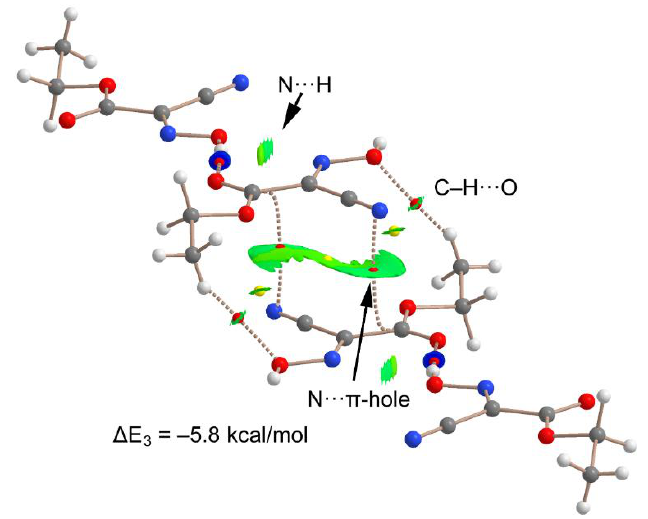
Figure 6. QTAIM/NCIPlot analysis of intermolecular bond CPs (red spheres), bond paths and RDG isosurfaces of a tetrameric assembly of the Oxyma (computed as a dimer of dimers).